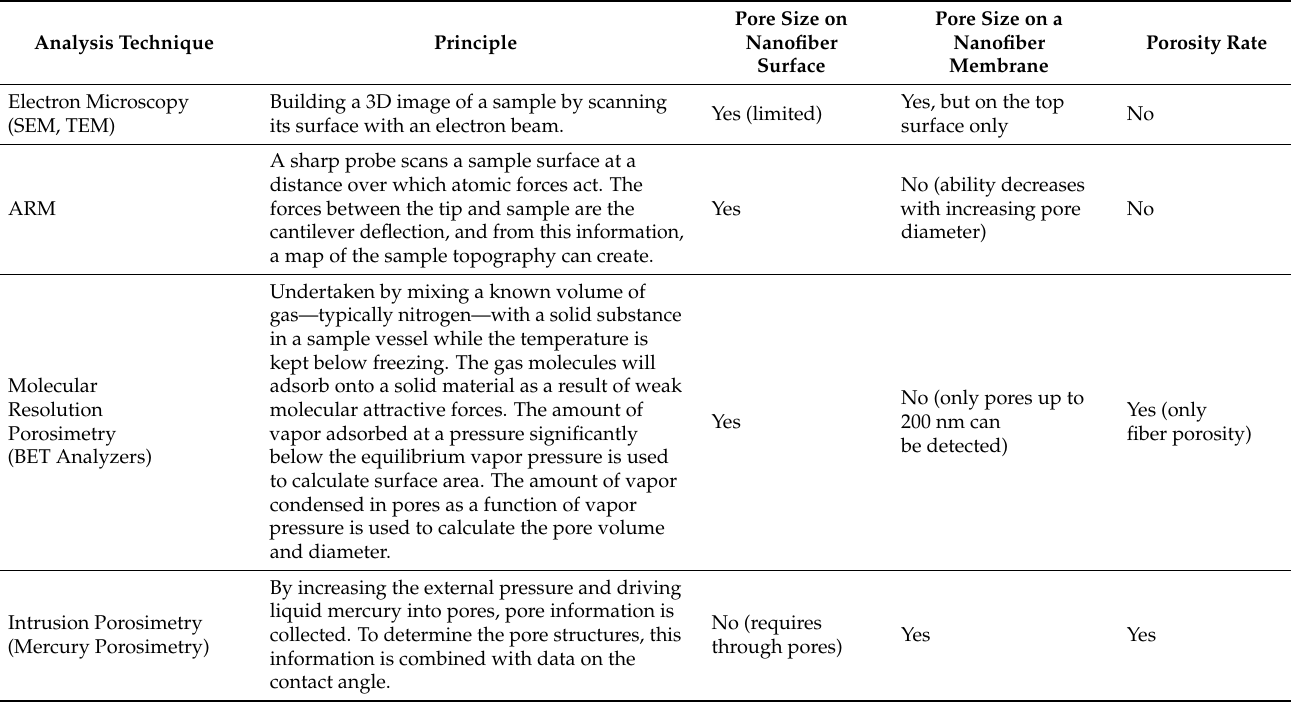
Table 2. Comparative analysis of several techniques to characterize the pore